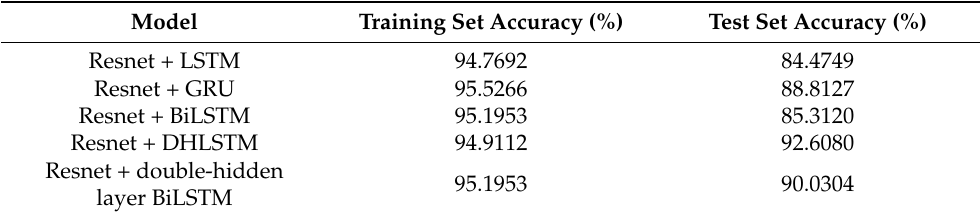
Table 3. Comparison of different time sequence classification models based on feature-level frame aggregation.